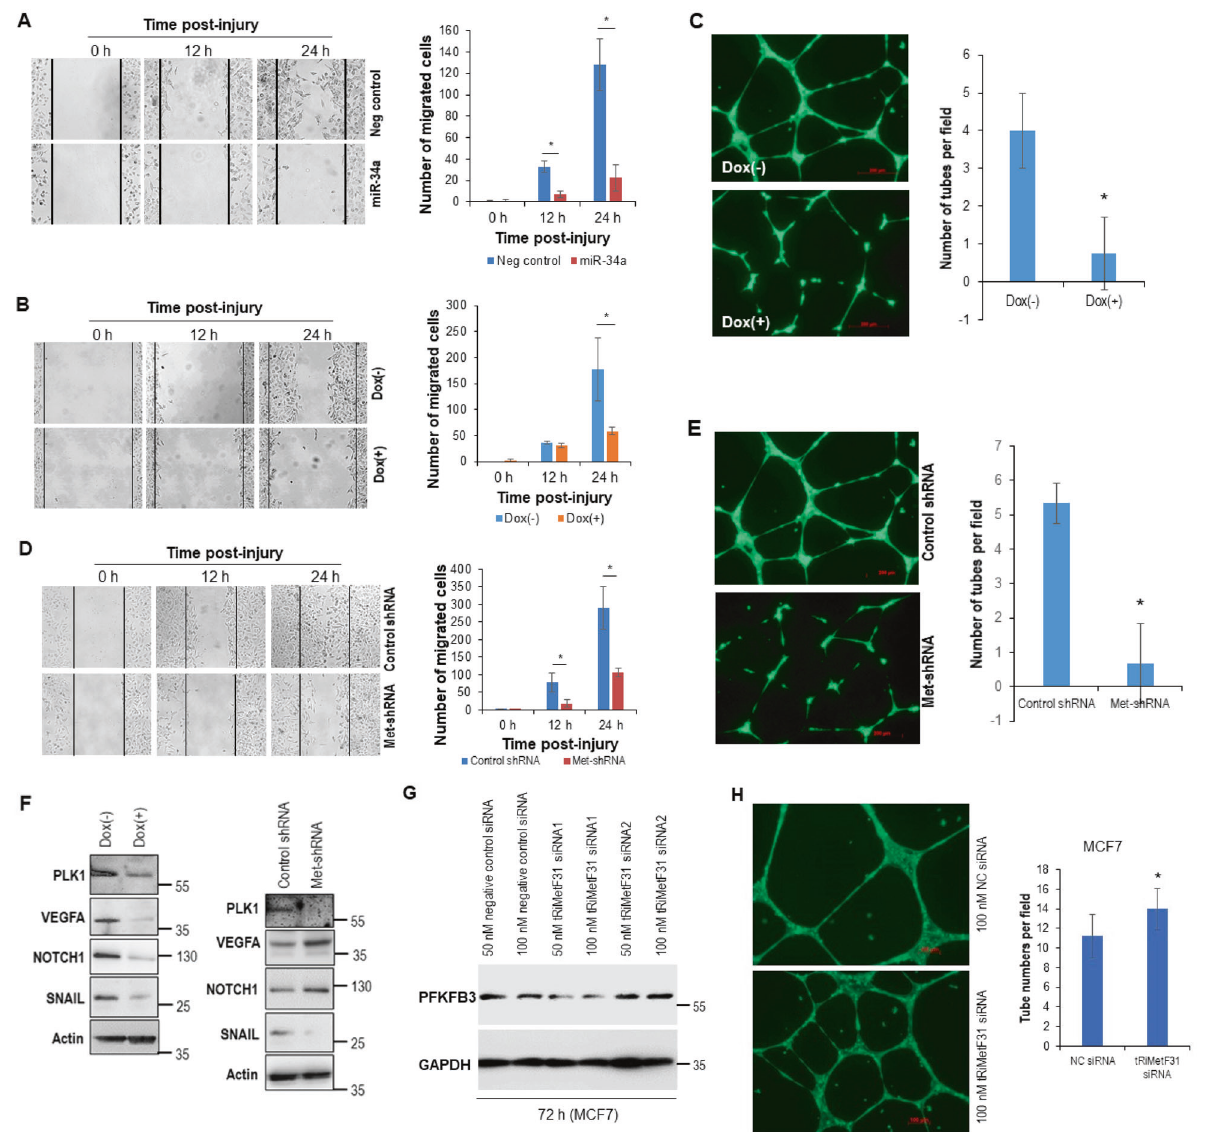
Fig. 6 Both ectopic miR-34a and tRNA iMet knockdown suppressed the migration and angiogenesis of breast cancer cells. A HCC1806 cells grown in six-well plates were transfected with either 33 nM miR-34a or 33 nM AllStars negative control; at 22 h after transfection, the cells were exposed to mitomycin C for 2 h, and a wound-healing assay was then performed. B Dox-inducible miR-34a-expressing HCC1806 cells grown in six-well plates were incubated in either Dox-containing or Dox-free medium for 72 h; at 2 h before wound, the cells were treated with mitomycin C, a wound-healing assay was then performed. C Tube-formation assay was performed using 50% conditioned medium from Dox(-) or Dox( + ) cells, as detailed in the “ Materials and methods ” . D HCC1806 cells stable expressing either tRNA iMet shRNA (Met-shRNA) or control shRNA were seeded in six-well plates and exposed to mitomycin C for 2 h before generating a wound. A wound-healing assay was then performed. E Tube-formation assay was carried out using conditioned medium from either Met-shRNA- or control shRNA-expressing cells, as detailed in the “ Materials and methods ” . F Whole cellular lysates prepared from either Dox(-) or Dox( + ) cells or Met-shRNA- or control shRNA-expressing cells were subjected to Western blot analysis using antibodies to PLK1, VEGF, NOTCH1, and SNAIL, actin served as a loading control. G MCF7 cells were transiently transfected with either 50 nM or 100 nM tRiMetF31 siRNA1 or tRiMetF31 siRNA2 or AllStars negative control siRNA; 72 h after transfection, whole cellular lysates were prepared and subjected to Western blot analysis using antibody to